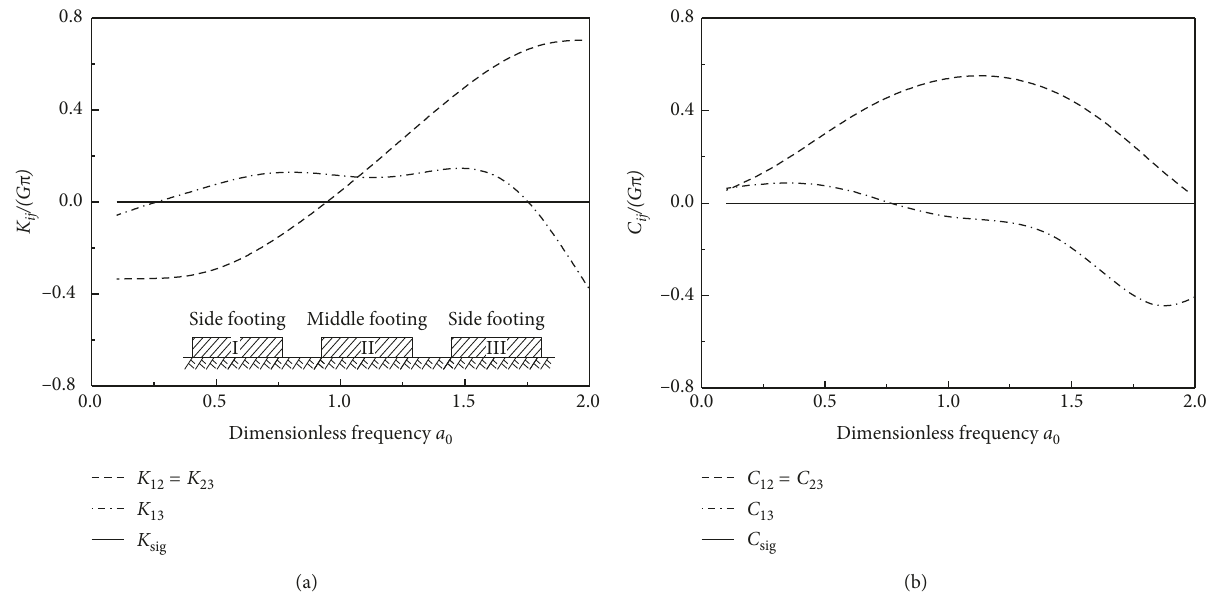
Figure 13: Vertical coupling impedance of K ij and C ij in the impedance matrix. (a) Real part. (b) Imaginary